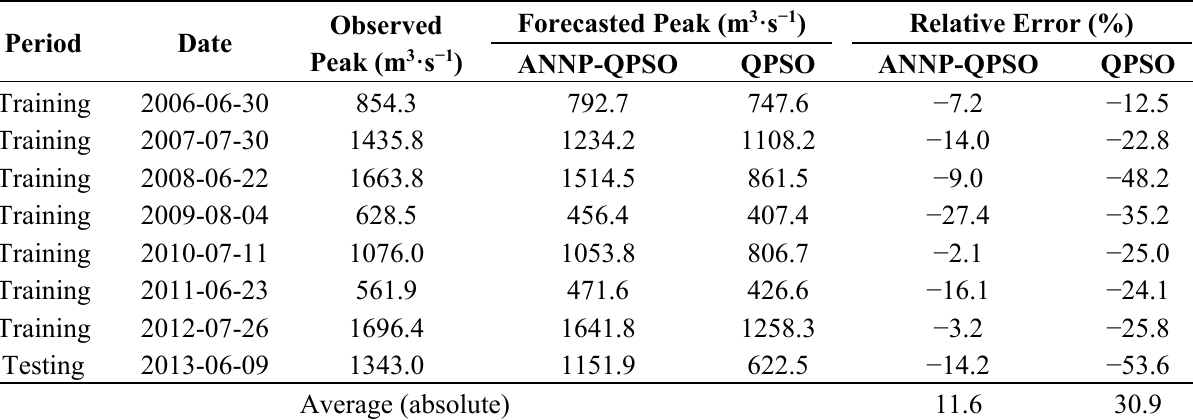
Table 4. Observed peak flow and forecasted peak flow of two models for Hongjiadu